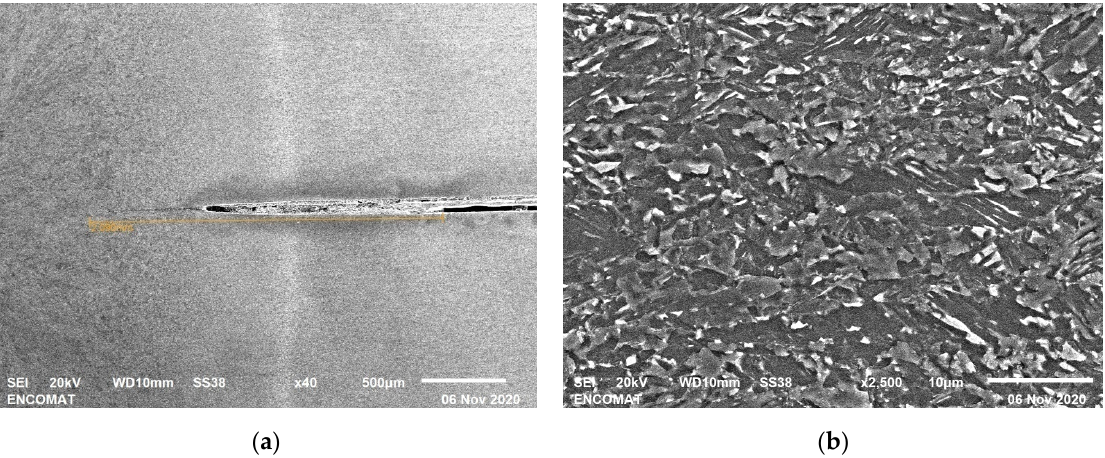
Figure 8. SEM of D Proy for f = 1000 Hz: ( a ) the interface; ( b ) the base metal.